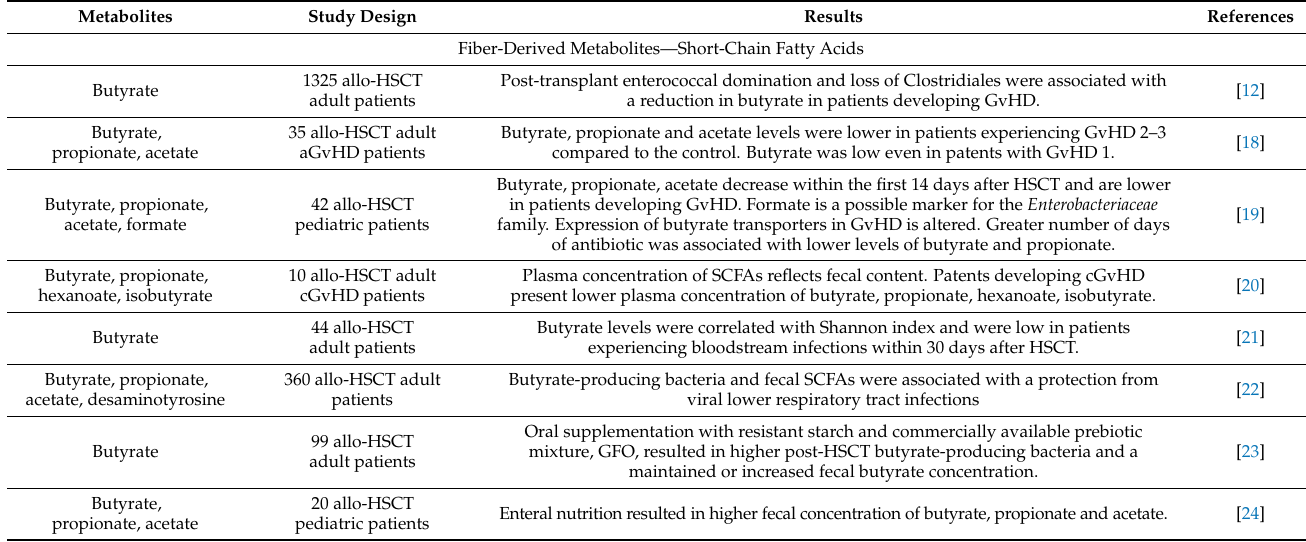
Table 2. Summary of studies investigating the role of microbiome-derived metabolites in HSCT setting in human.